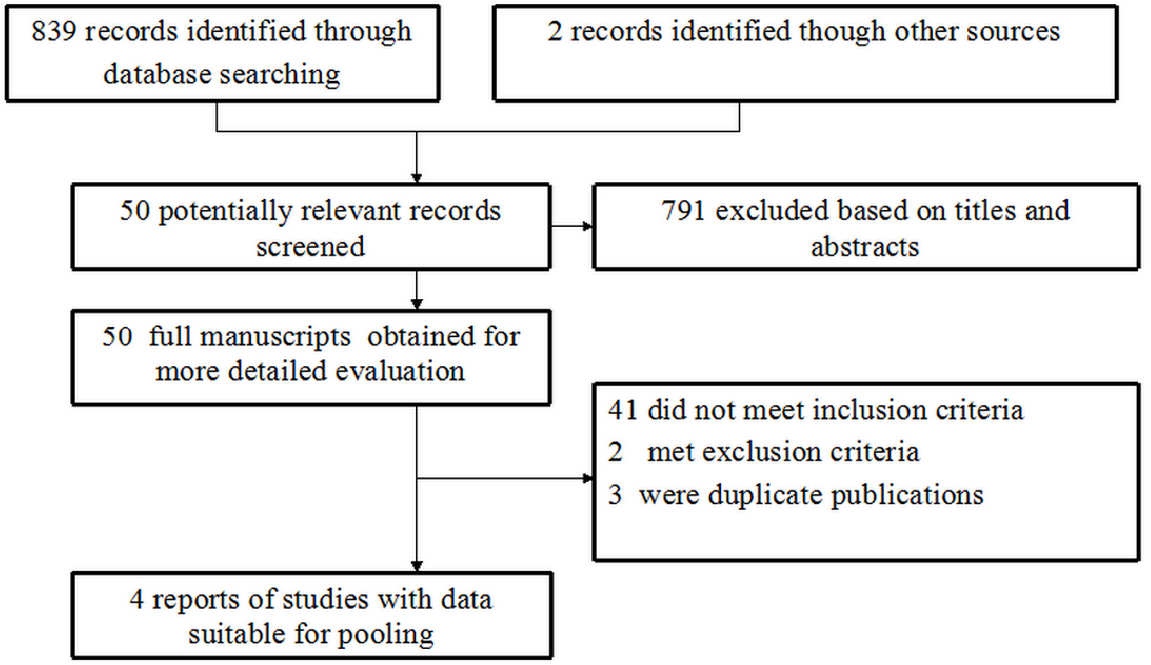
Figure 1. Flow diagram of paper selection for the